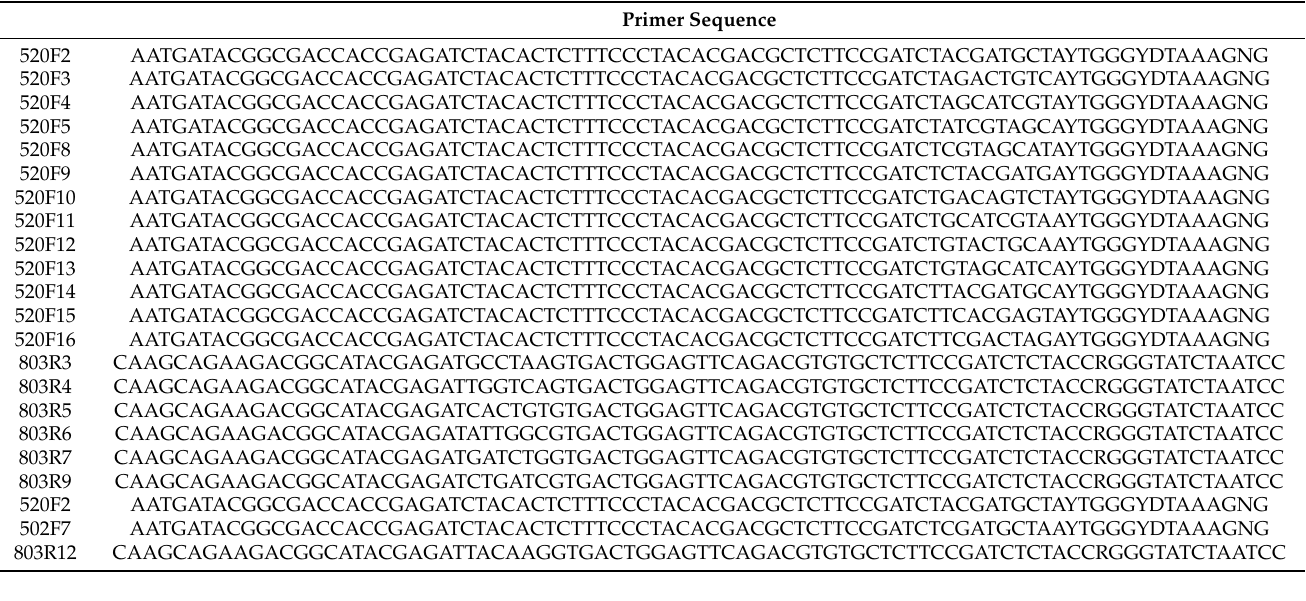
Table 1. Full length amplification primers of 16s rDNA